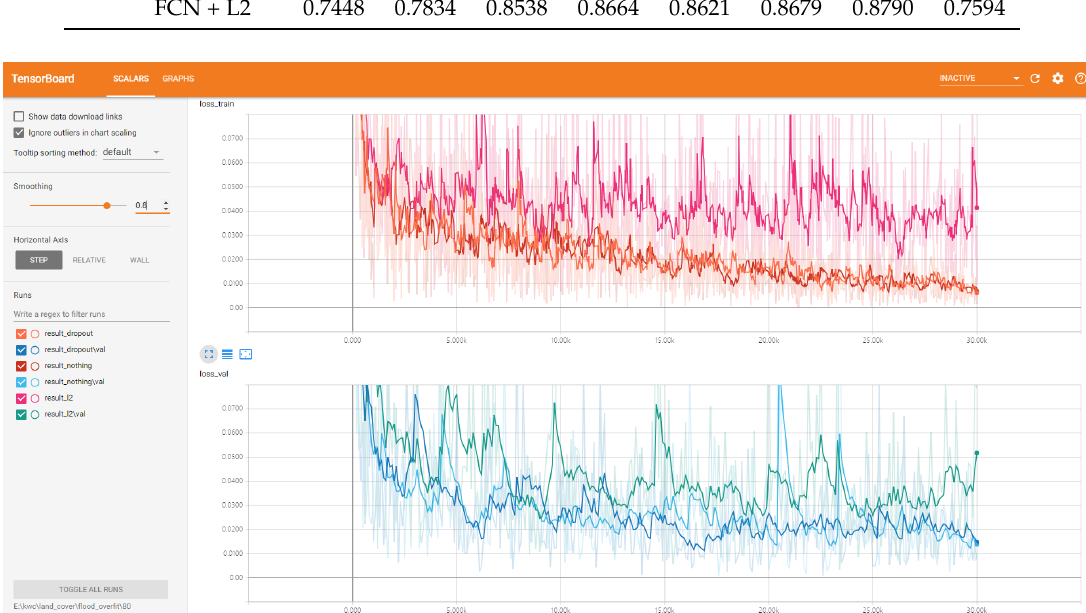
Figure 15. The loss value curves of training samples and validation samples during the training period in three cases: using dropout (i.e., FCN16), using L2 regular function and using nothing (reduce dropout in